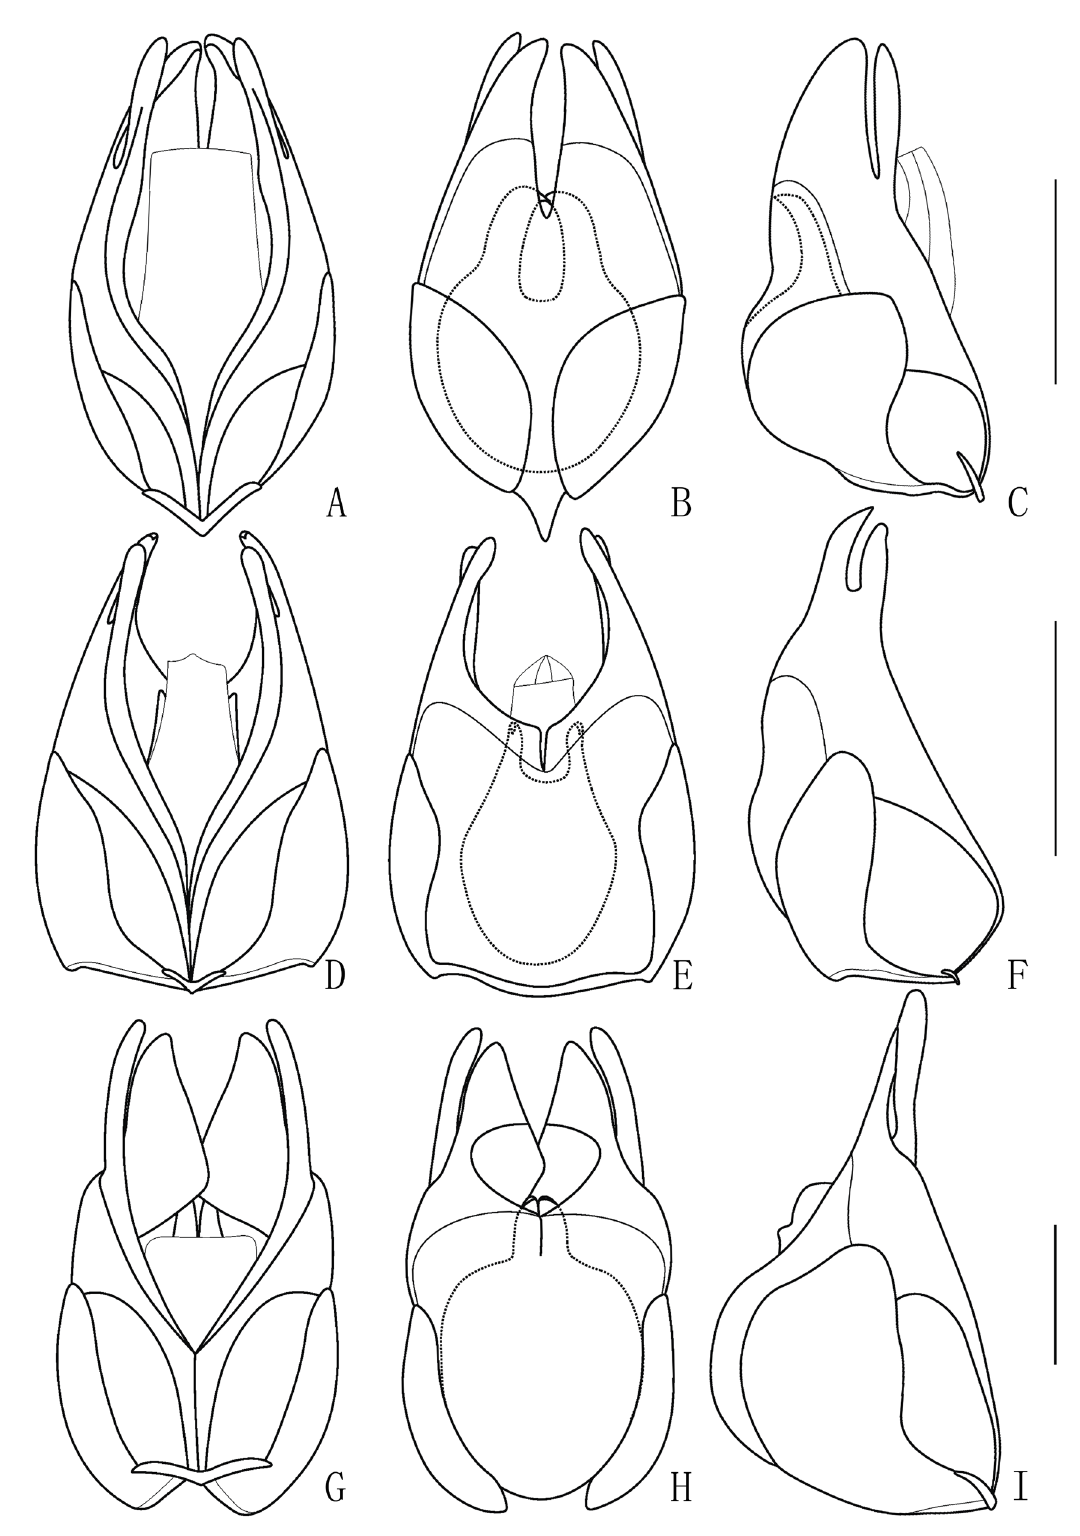
Fig. 2. Aedeagus (A, D, G = ventral view; B, E, H = dorsal view; C, F, I = lateral view). A‒C . Stenothemus shaanxiensis Švihla, 2004 stat. nov. (CQNU, Chongqing). D‒F . S. davidi (Pic, 1926) comb. nov. (IZAS, Sichuan). G‒I . S . diffusus Wittmer, 1974 (MHBU, Sichuan). Scale bars = 0.5